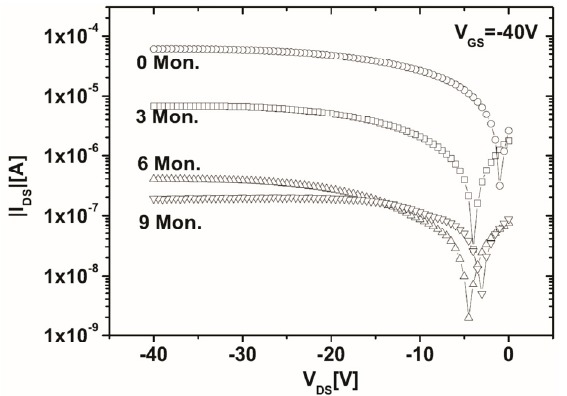
Figure 8. V DS —I DS characteristics of an inverted coplanar pentacene OTFT at V GS = − 40